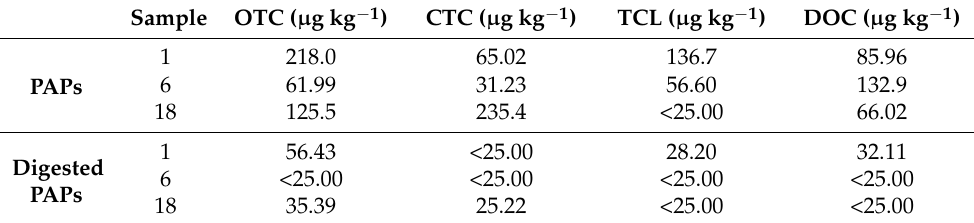
Table 4. Concentrations (expressed in µg kg −1 ) of OTC, TCL, CTC, and DOC and RAC obtained by LC-MS/MS analysis for the three PAPs (samples n . 1, 6, and 18) and their corresponding digested ones. OTC = oxytetracycline, CTC = chlortetracycline, TCL = tetracycline DOC = doxycycline.